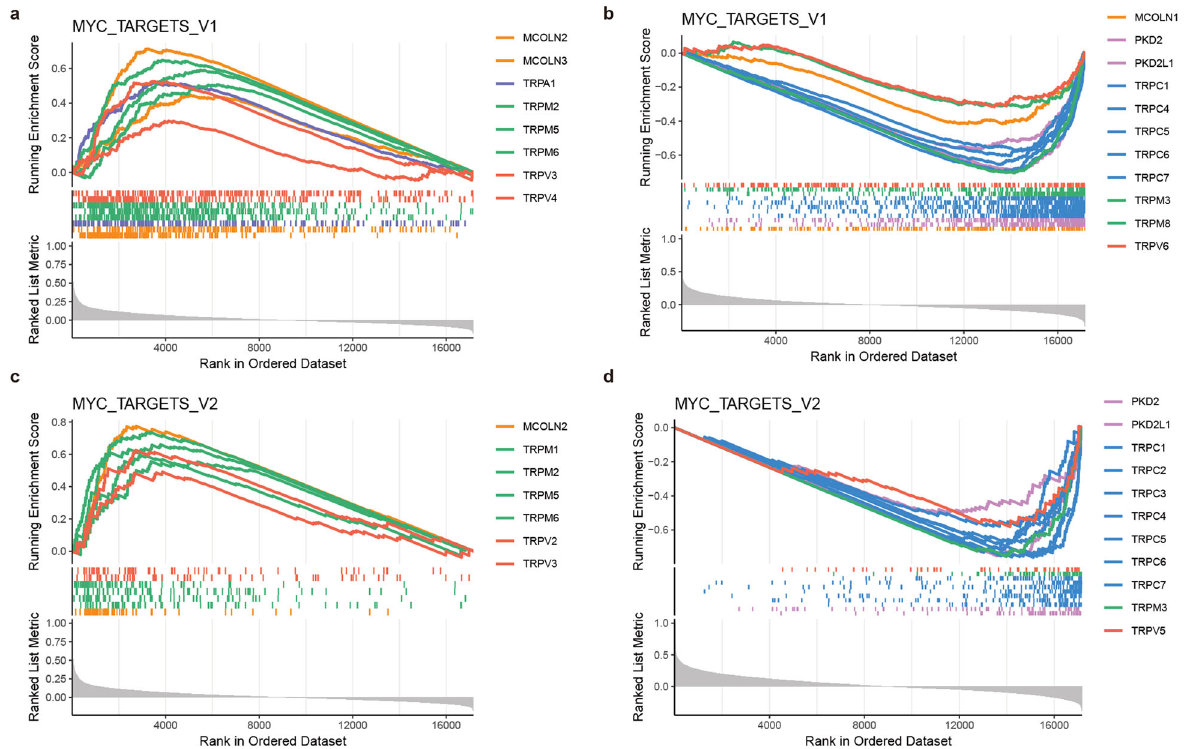
Fig. 7 Genes co-expressed with TRPs are enriched in MYC targets. a The enrichment score (ES) distribution for the genes positively co- expressed with TRP genes in MYC_targets_V1. Each vertical dashed line represents a gene involved in the pathway. Each line is for one TRP gene. b The enrichment score (ES) distribution for the genes negatively co-expressed with TRP genes in MYC_targets_V1. c The enrichment score (ES) distribution for the genes positively co-expressed with TRP genes in MYC_targets_V2. d The enrichment score (ES) distribution for the genes negatively co-expressed with TRP genes in